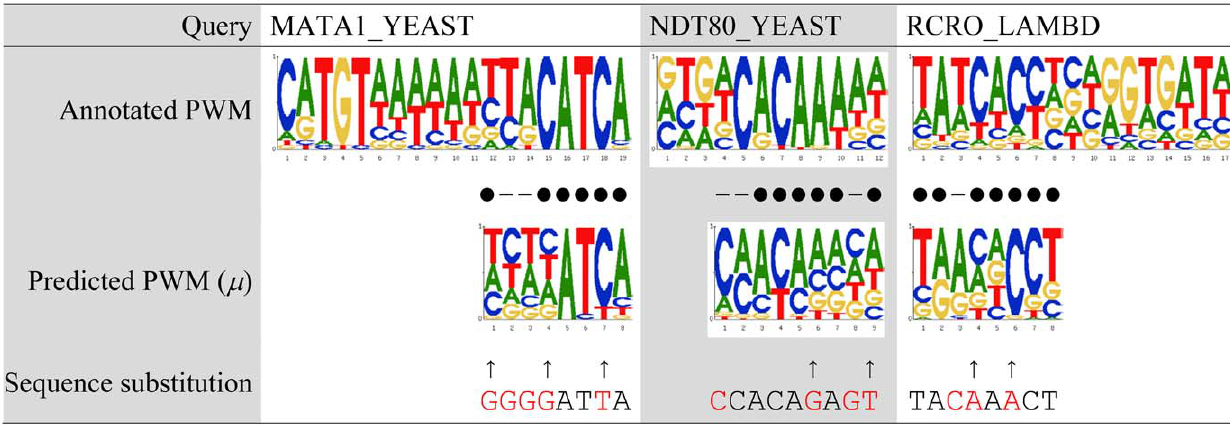
Figure 6. Demonstration of base substitution. This case demonstrates the ability of the employed all-atom potential function to replace the base types when the native DNA sequence in the selected template is not the same as the target DNA sequence to that the query protein can bind. A N ’ if its most favorable base type was correctly predicted, or marked as ‘–’ otherwise. In addition, the symbol ‘ q ’ stands for a position is marked as ‘ successful substitution. The sequence shown is the DNA sequence in the selected template, where red nucleotides indicate the positions of which the bases are different to the most favorable base types in the annotated PWMs.